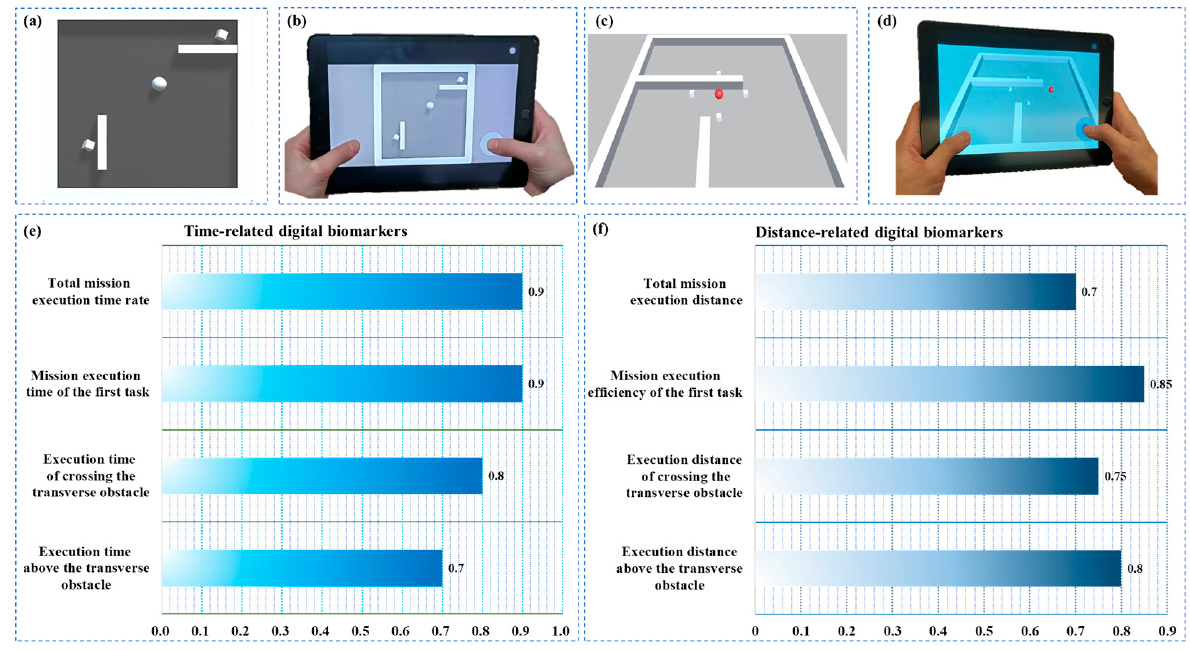
Figure 1. Schematic diagram of ( a ) training level, ( b ) training process, ( c ) 2-min rapid alerting evaluation paradigm of human–computer interaction (HCI), ( d ) evaluation process, ( e ) time-related digital biomarkers selection results, ( f ) distance-related digital biomarkers selection results.